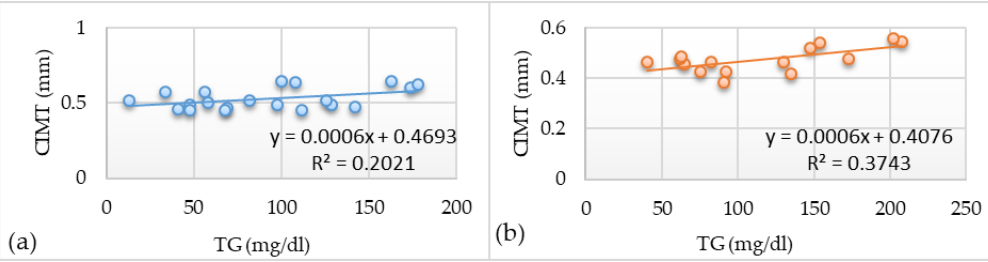
Figure 10. ( a ). Correlation between CIMT and TG in obese children. ( b ) Correlation between CIMT and TG in overweight children.